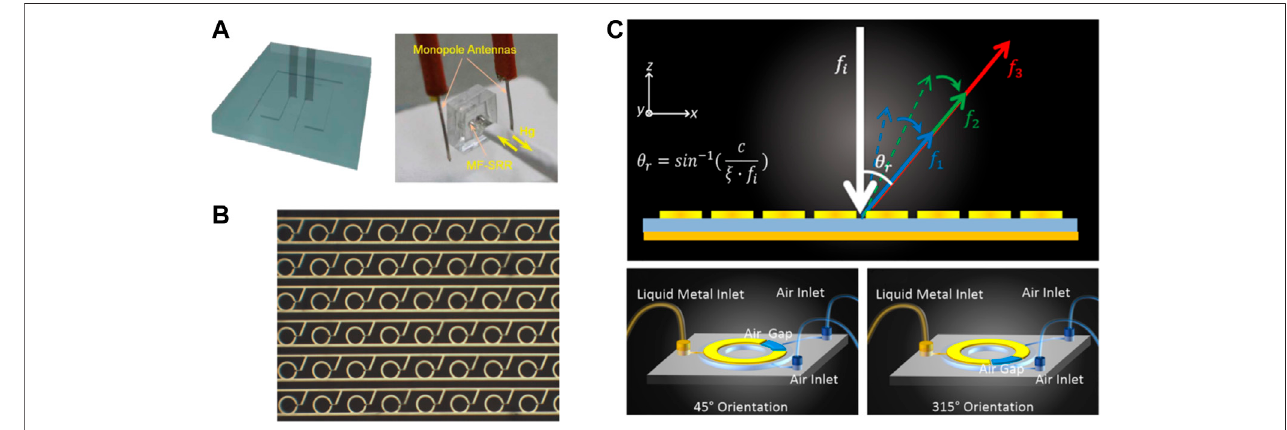
FIGURE 8 | Structures of liquid-metal-cell metamaterials. (A) Recon fi gurable electromagnetic metamaterials using Hg in metamolecular [70]. (B) Recon fi gurable THz metamaterial device with EGaIn in microchannels [150]. (C) Individually modulating ring-resonator-array metamaterial using liquid-metal Galinstan [166]. Figure reproduced with permission from: (A) , © 2009, AIP Publishing; (B) , © 2014, Optical Society of America (OSA); (C) , © 2017, AIP